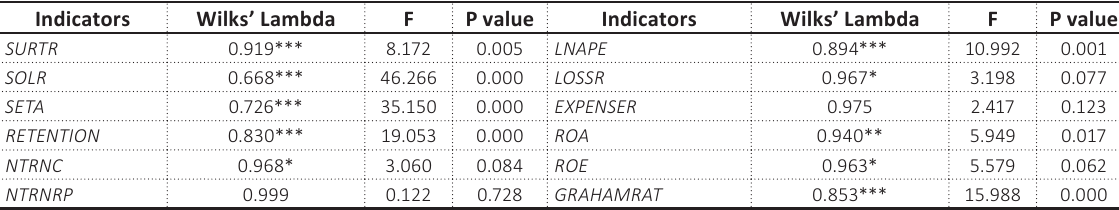
Table 2. Test of means’ equality